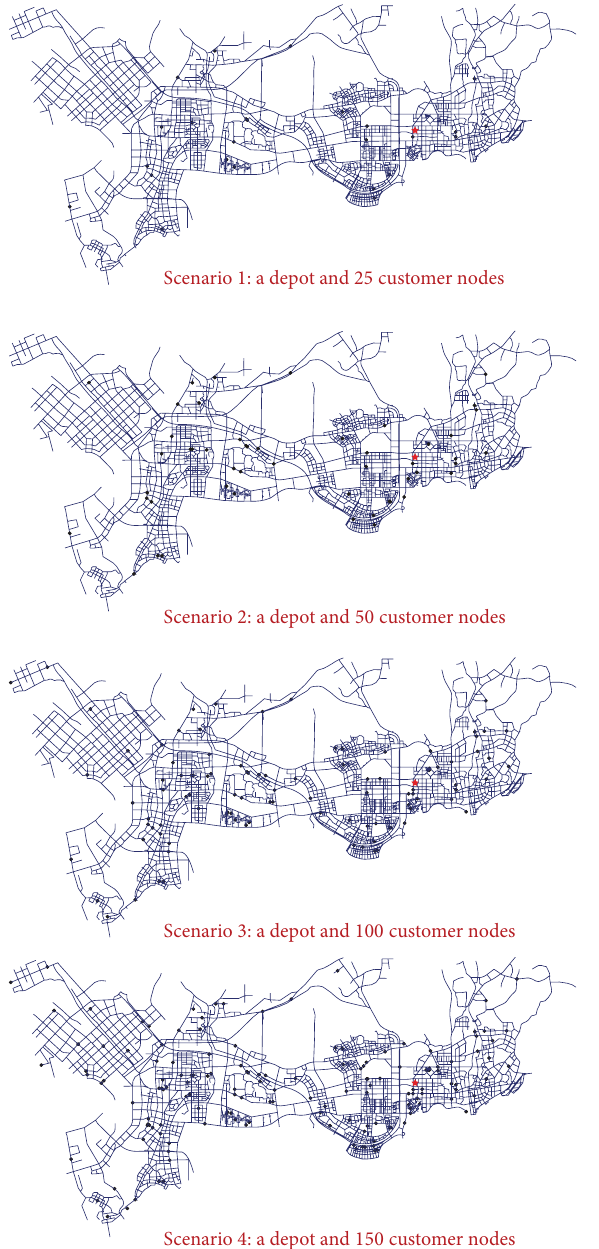
Figure 5: Spatial distribution of depot and customer nodes on the network (4